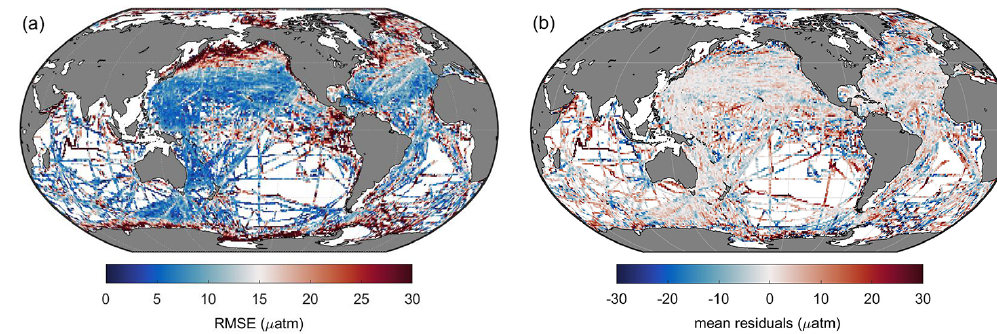
Figure 6. Global maps of (a) RMSE and (b) mean residuals between predicted p CO 2 and SOCAT observations.